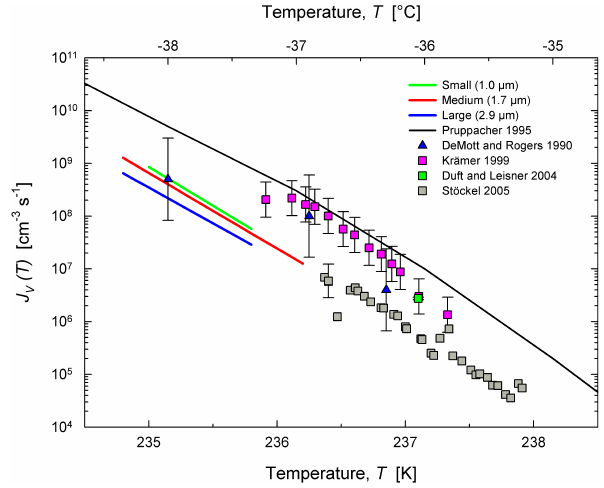
Fig. 14. Comparison of J V (T ) curves determined from group fits in the present work with literature values determined using levitated droplets in electrodynamic balances (squares) and expansion cloud chambers (triangles). Error bars are provided for literature values only (uncertainties in the present study are indicated in Fig.